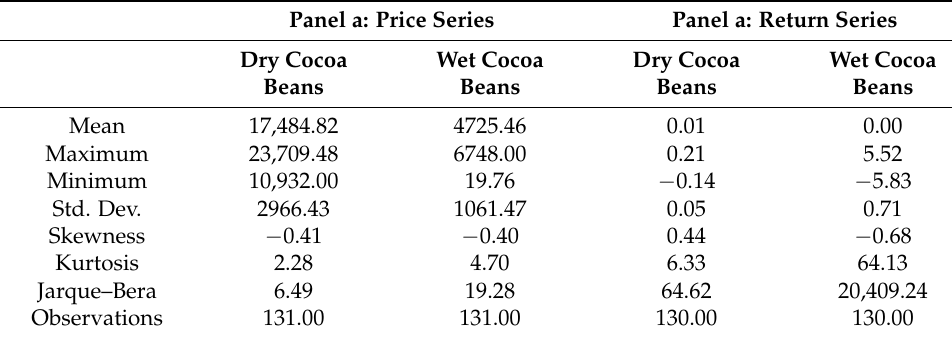
Table 2. Descriptive statistics of dry and wet Cocoa beans price/return